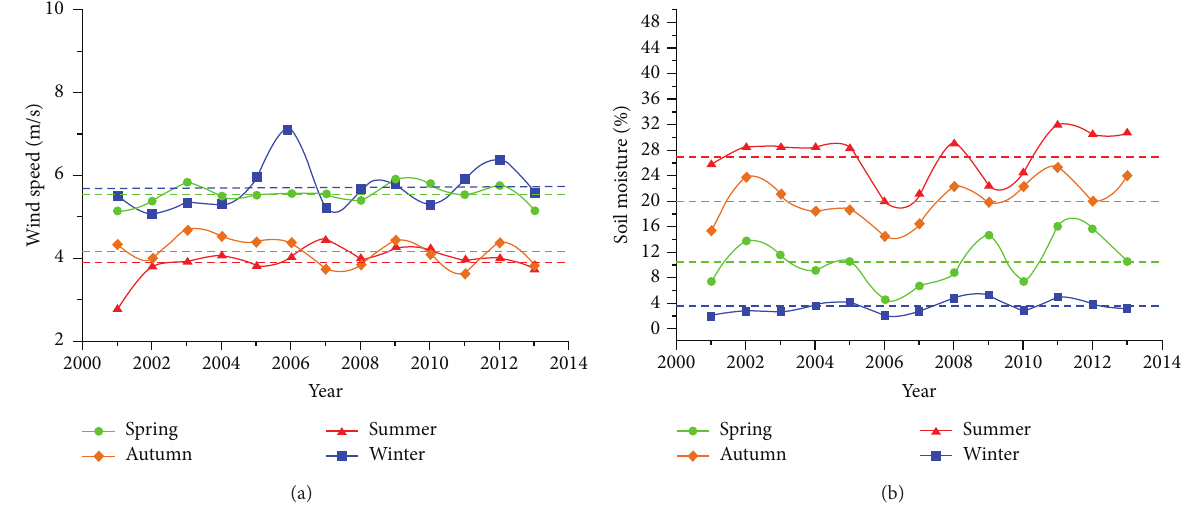
Figure 5: The interannual variation of wind speed and soil moisture in each season at